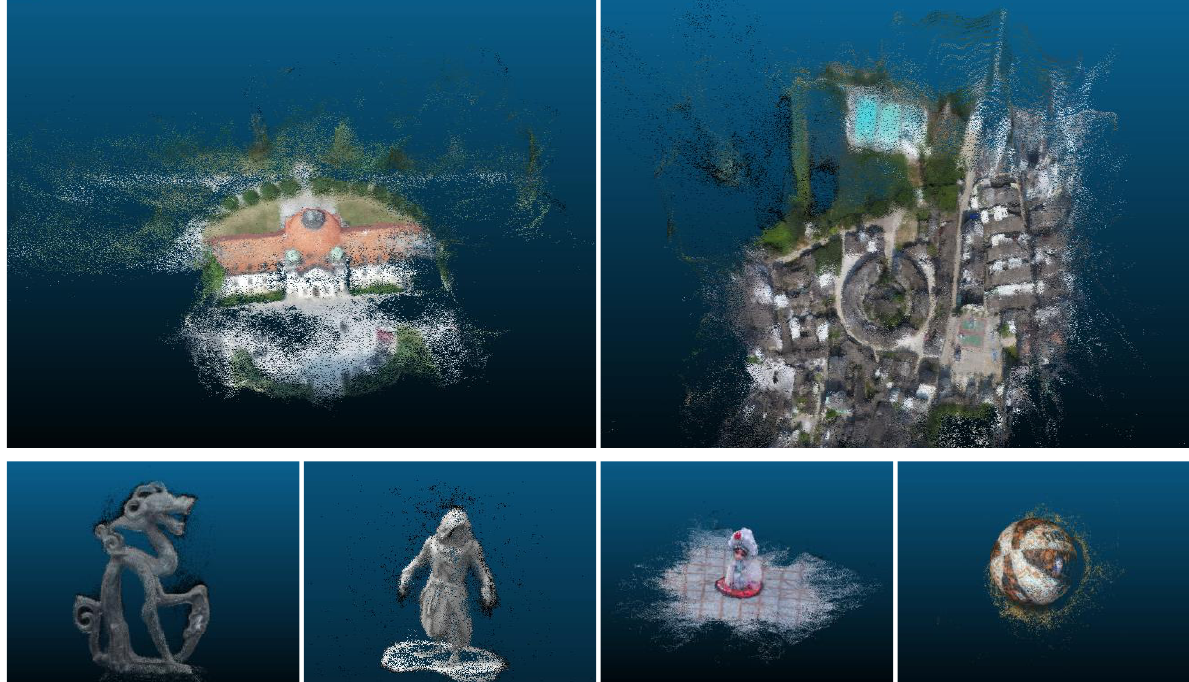
Figure 6. Reconstruction results of BlendedMVS dataset.